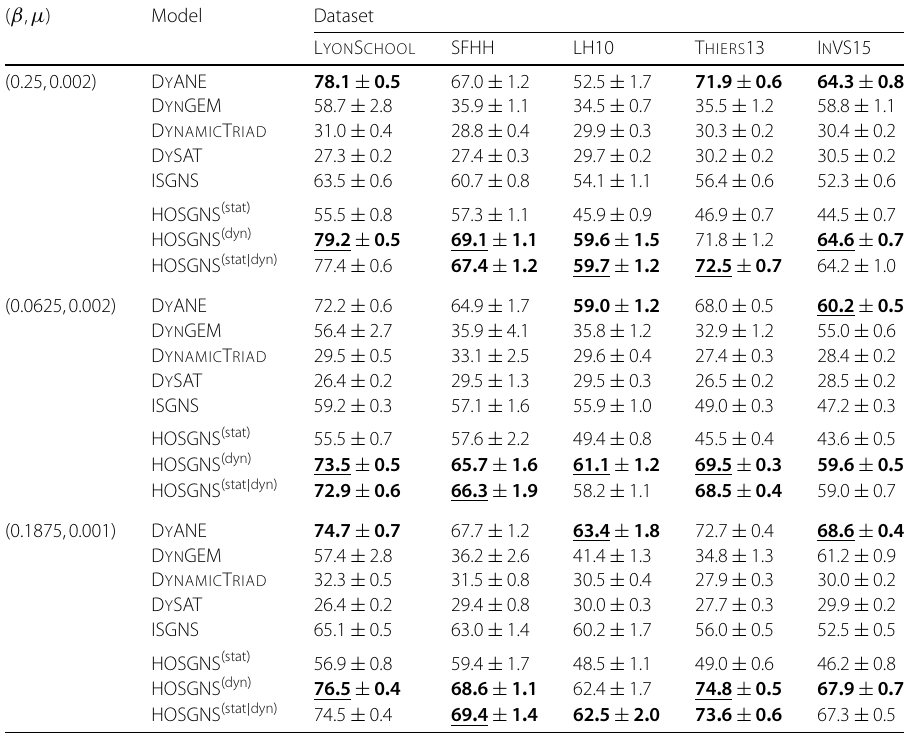
Table 2 Macro-F1 scores for classification of nodes in epidemic states according to different SIR epidemic processes over empirical datasets. For each ( β , μ ) we highlight the two highest scores and underline the best